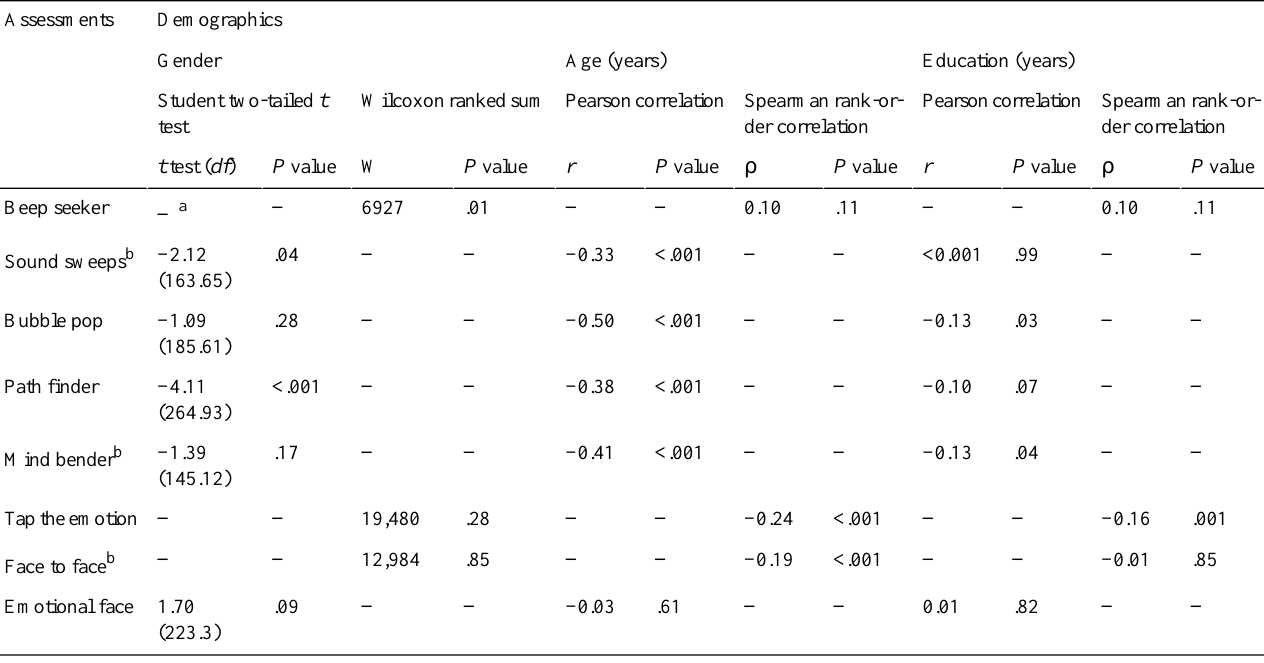
Table 3. Association of online neurocognitive assessments with demographic variables (gender, age, and education).